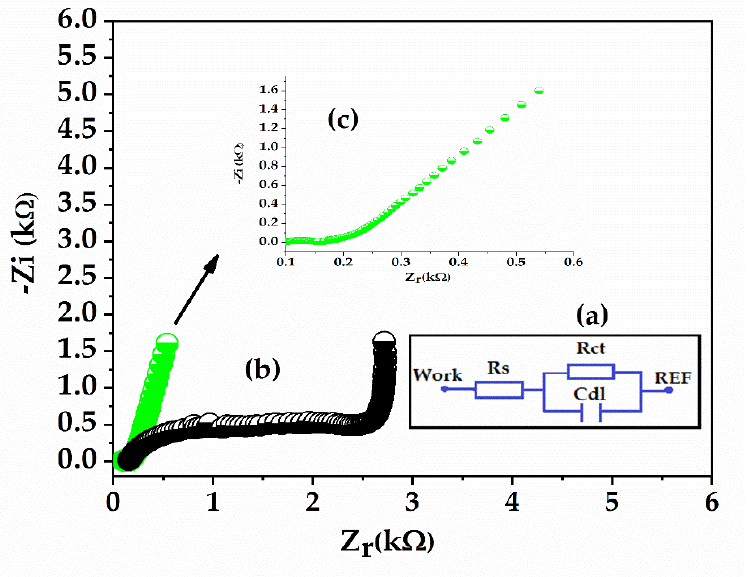
Figure 9. ( a ) Equivalent circuit for fitting EIS results with the solution resistance (R s ), double layer capacitance (C dl ) and the electron transfer resistance (R ct ) ( b ) Nyquist plot (-Z i vs Z r ) for PANI:PSS/SWCNT/Fc (green) and PANI:PSS/SWCNT (black) ( c ) Nyquist plot (-Z i vs Z r ) for PANI:PSS/SWCNT/Fc (green) at a lower scale.